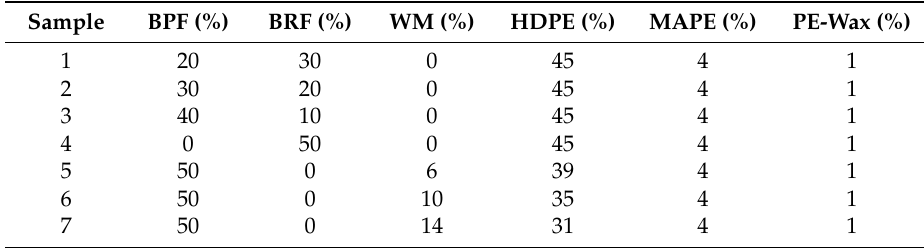
Table 1. Formulation of bamboo plastic composites